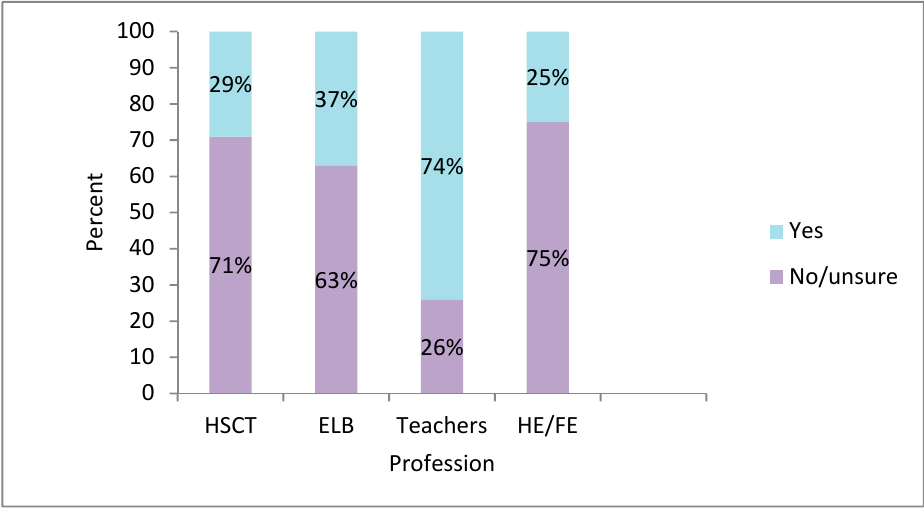
Figure 4. Percentage of professionals’ basic post-qualifying, in-service autism training.